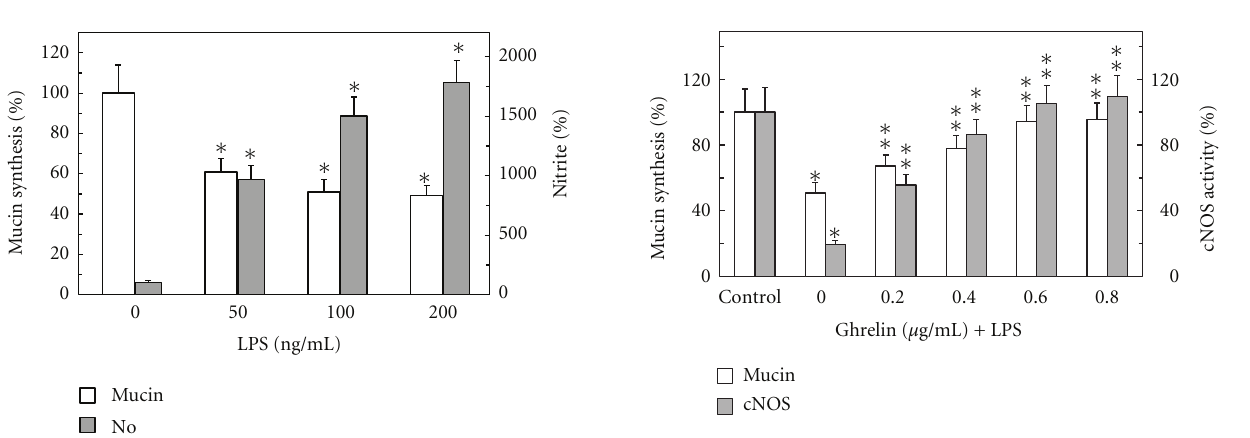
Figure 3: E ff ect of ghrelin on P. gingivalis LPS-induced changes in mucin synthesis and the expression of cNOS activity in the salivary gland acinar cells. The cells, preincubated with the indicated concentrations of ghrelin, were treated with the LPS at 100ng/mL and incubated for 16h in the presence of [ 3 H]glucosamine as a marker of mucin synthesis. Values represent the means ± SD of five experiments. ∗ P < . 05 compared with that of control. ∗∗ P < . 05 compared with that of LPS alone.